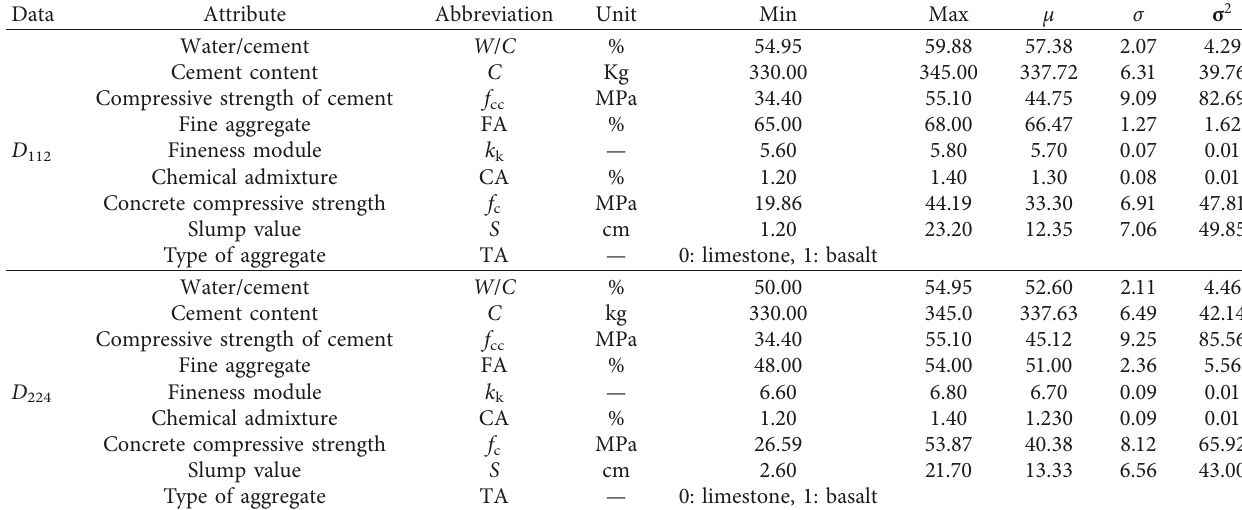
Table 2: Basic statistic of used